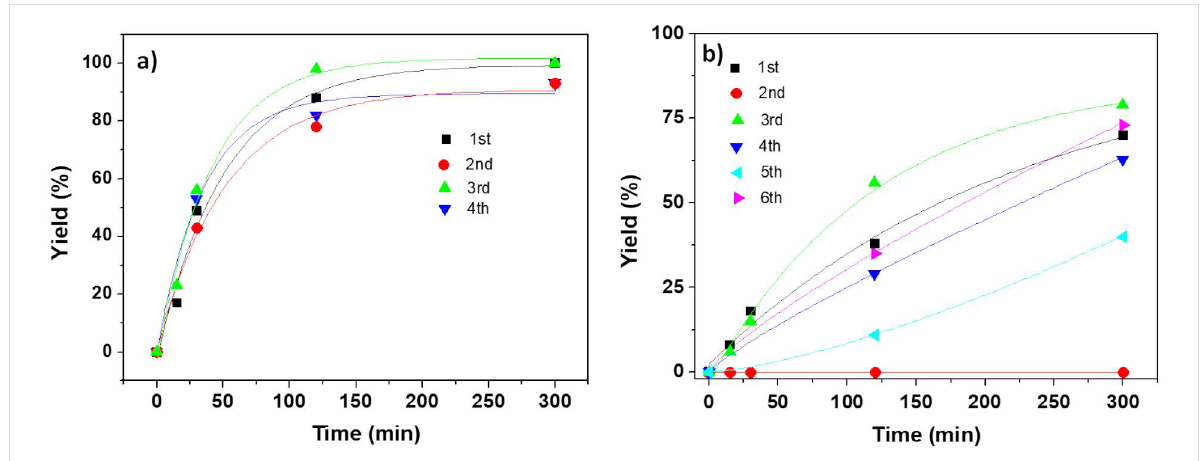
Figure 6: Negishi reaction between 5 and 6 catalyzed by 11 . 1 equiv methyl 4-bromobenzoate ( 6 , 0.25 mmol), 2 equiv benzylzinc bromide ( 5 , 0.5 mmol, 1 mL of a 0.5 M solution in THF), 5 mol % Pd catalyst in dry THF (1 mL). a) 11 in presence of RuPhos, Pd/RuPhos 1:0.05 molar ratio. RuPhos added for each cycle. b) 11 + 9a , 1:3 weight ratio, in the presence of RuPhos, Pd/RuPhos 1:1 molar ratio, RuPhos added each cycle except for the 2nd cycle. N 2 atmosphere. Yields calculated by GC and confirmed by 1 H